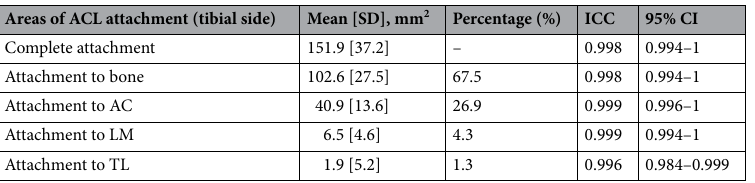
Table 1. Areas of attachment of the tibial side of ACL (n = 10). AC articular cartilage, ACL anterior cruciate ligament, CI confidence interval, ICC intraclass correlation coefficients, LM lateral meniscus, TL transverse